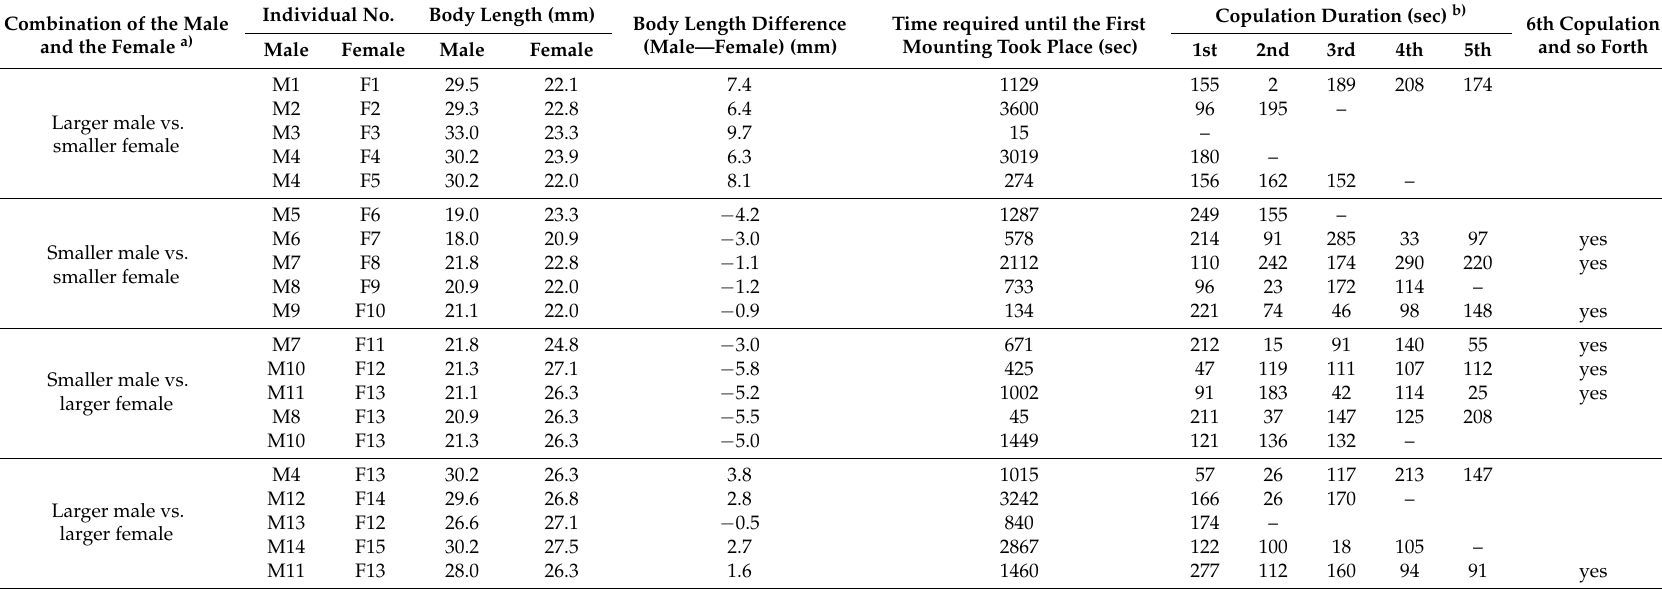
Table 1. Results of laboratory mating in Rosalia batesi . Before being subjected to the experiments, adult beetles were divided into groups of males and females, and into groups of larger and smaller than the average